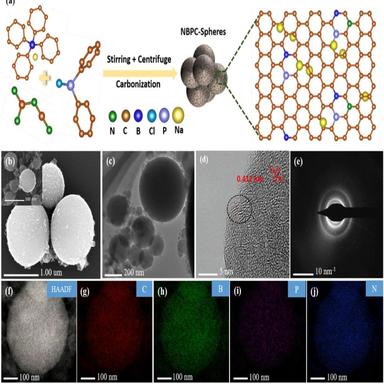
(a) Schematic illustration of N, B, and P co-doped porous-Carbon synthetic procedures. (b) SEM, (c) TEM, (d) HRTEM, (e) SAED, and (f-j) STEM images of NBPC-800 and corresponding EDS mapping of C, B, P, and N.